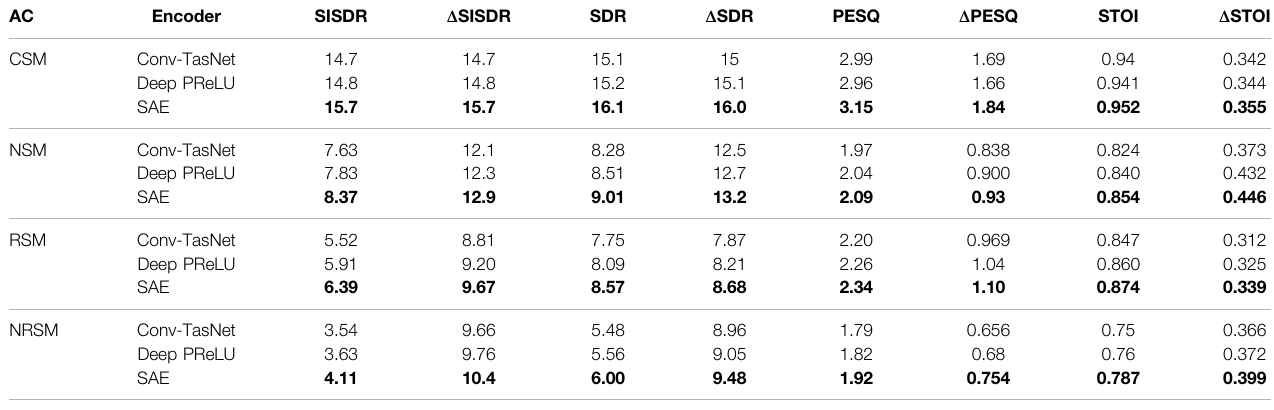
TABLE 3 | Comparison of MHA encoder with 4 attention heads to Original Conv-TasNet encoder across various acoustic conditions. Bold indicates the best performing model for each acoustic condition and metric.